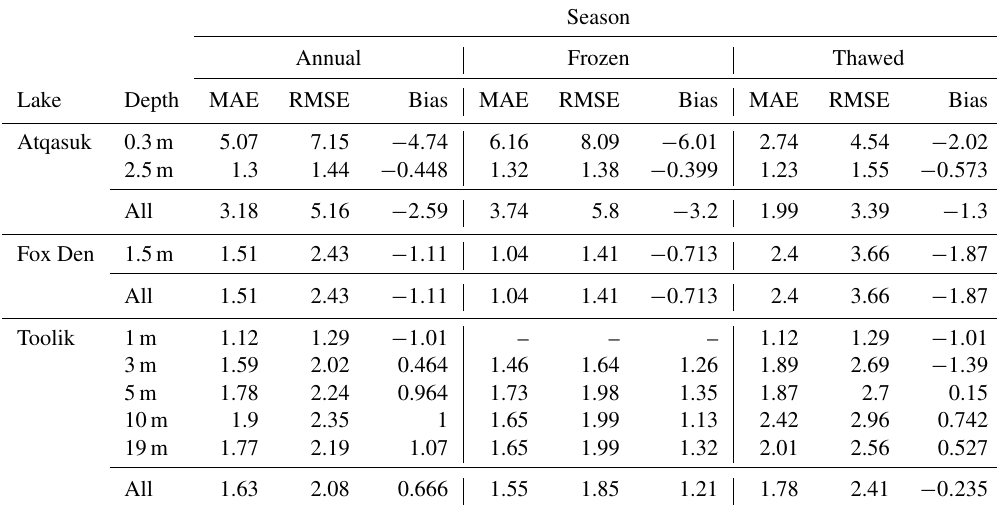
Annual Frozen Thawed Lake Depth